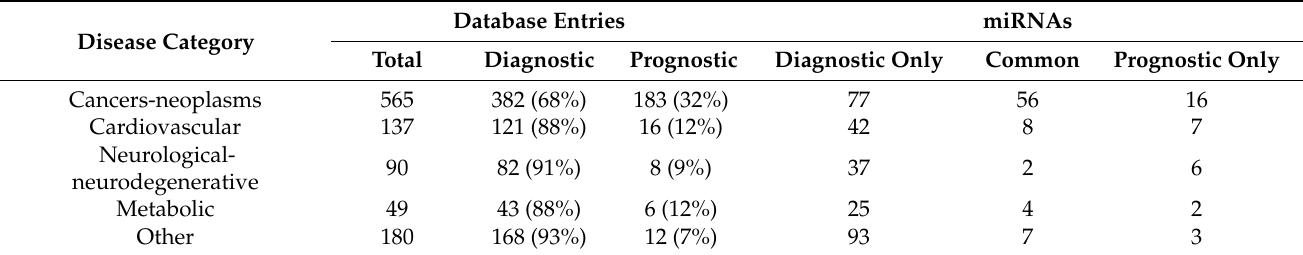
Table 2. Per disease category content metrics. Entry (total/diagnostic/prognostic) and miRNA numbers (only diagnos- tic/only prognostic/diagnostic and prognostic) are presented. Disease